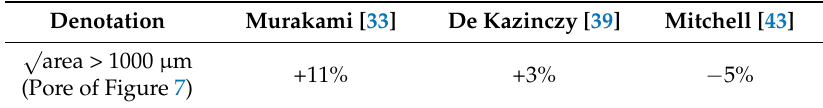
Table 7. Deviation of fatigue models compared to experimental result for pore of Figure